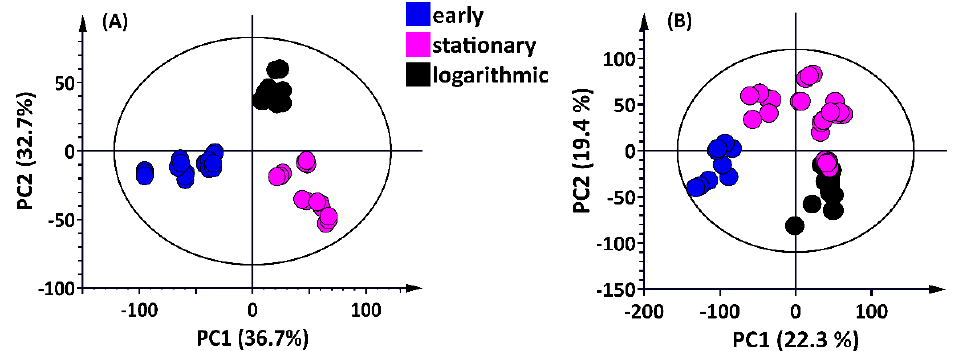
Figure 2. Principal component analysis (PCA) score plots of ( A ) methanolic- and ( B ) and acetonic intracellular extracts of H. roseonigra cells analyzed using UHPLC–MS in ESI ( − ) mode. The scores plots, constructed from the first two components, show clustering according to different growth stages represented as the early-, log-, and stationary stages. The ellipse indicates Hotelling’s T 2 at 95% confidence interval. The Pareto -scaled 2D scores plots ( A ) with PC1 and PC2 showing 36.7% and 32.7%, respectively, explaining a total variation of 69.4%, and ( B ) with PC1 and PC2 showing 22.3% and 19.4%, respectively, explaining a total variation of 41.7%, shows clear separation of the stages.